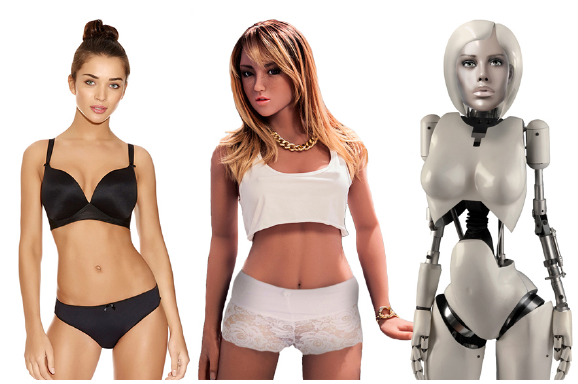
Figure 1: Examples of the stimulus material of the groups: women (left), human-like gynoid robots (middle), machine-like gynoid robots